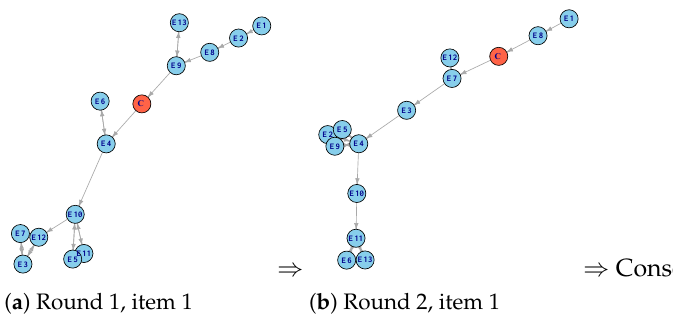
Figure 6. Fuzzy data corresponding to the 13 expert’s opinions (in blue color) ranked for the first round and the first item and the comparison FN C (in red